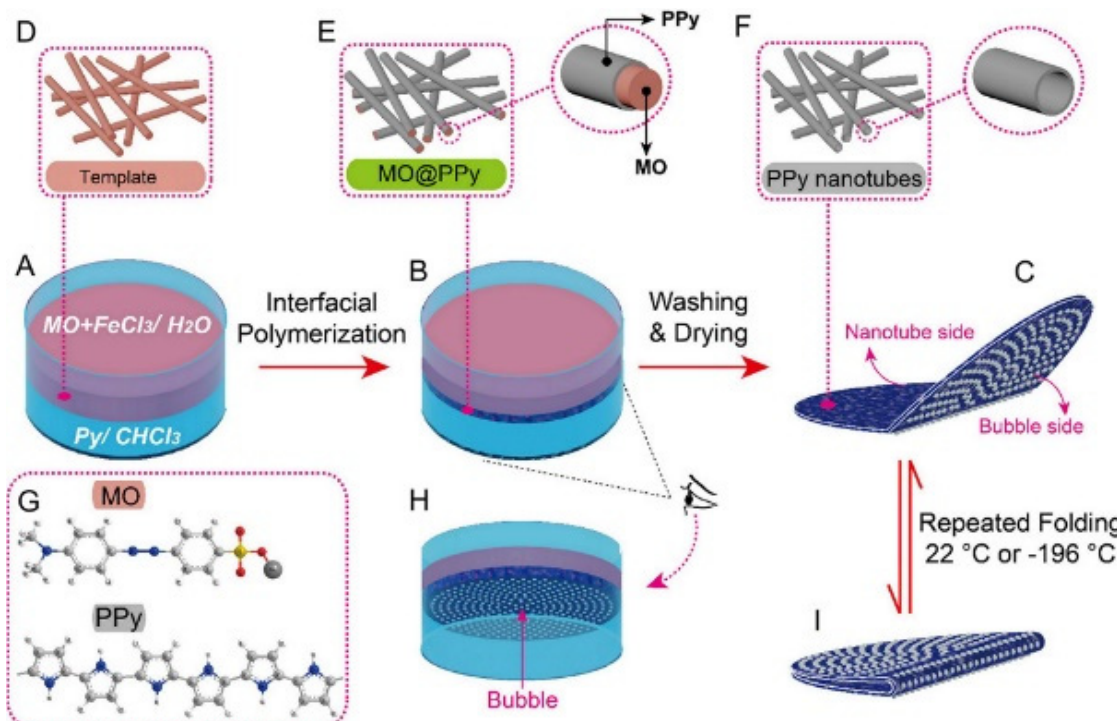
Figure 2. Diagram of the template-assisted interfacial polymerization (TIP) of a flexible PPy membrane (PPy-N). ( A ) Beginning of TIP ( B ) End of TIP ( C ) Final PPy-N membrane obtained after washing and drying. ( D ) Nanorod template structure formed by FeCl 3 and MO. ( E ) MO@PPy nanorod structure on the water side of the membrane. ( F ) PPy nanotube structure following removal of templates. ( G ) MO and PPy molecular structure. ( H ) Bubbles on the chloroform side. ( I ) Final PPy-N membrane is flexible [52]. Copyright 2017 ACS Nano.